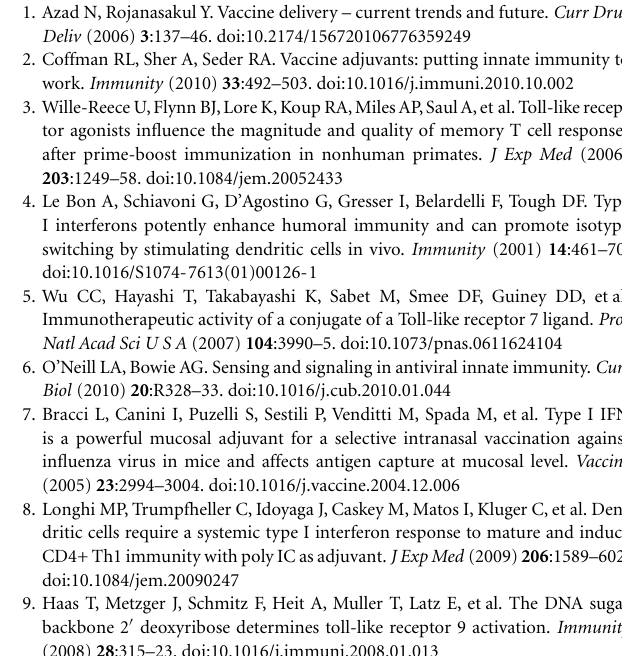
FIGURE 5 |The effect of co-vaccination on FLU-specific antibody responses . (A) Mice were injected i.v. with γ -FLU (10 4 or 10 5 TCID50 equivalent/mouse) or co-injected with γ -SFV(10 7 PFU equivalent/mouse) and serum FLU-specific IgG concentrations were analyzed at day 20 post-vaccination by direct ELISA using a serum dilution of 1/200. Sera from γ -SFV injected mice served as negative controls. (B) HA inhibition assay showing dilution of the immune sera capable of inhibiting the hemagglutinating activity of 80 HAU of A/PR8. Results are presented as mean ± SEM ( n = 3).